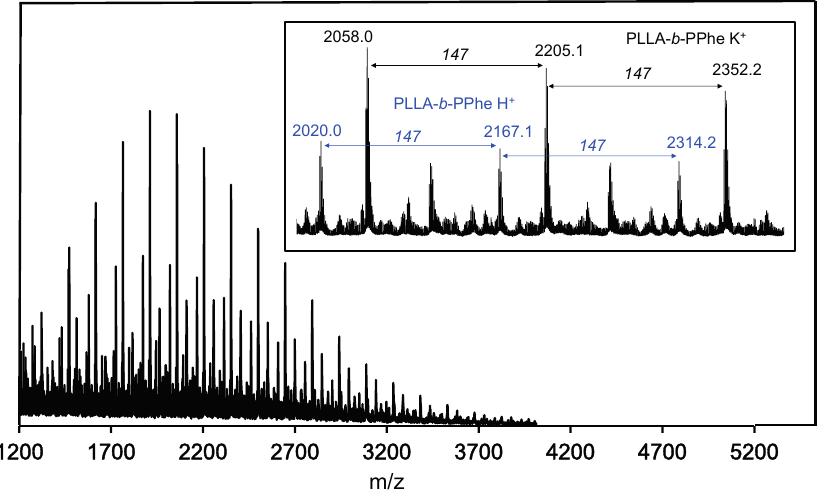
- b -PPhe . The inset shows a partial 25 13